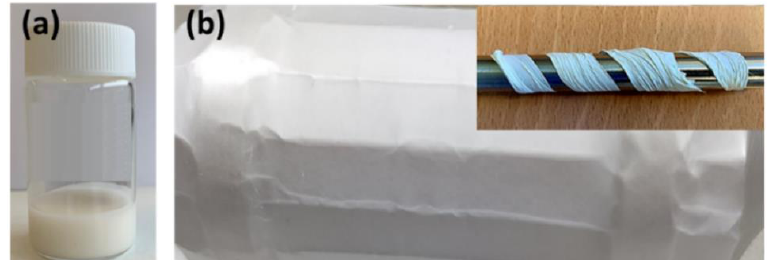
Figure 4. Perovskite polymeric solution ( a ) and MDABCO-NH 4 I 3 @PVC electrospun nanofiber mat ( b ) the inset shows a fiber mat folded around a cylindrical stick, demonstrating the flexibility of the fibers.